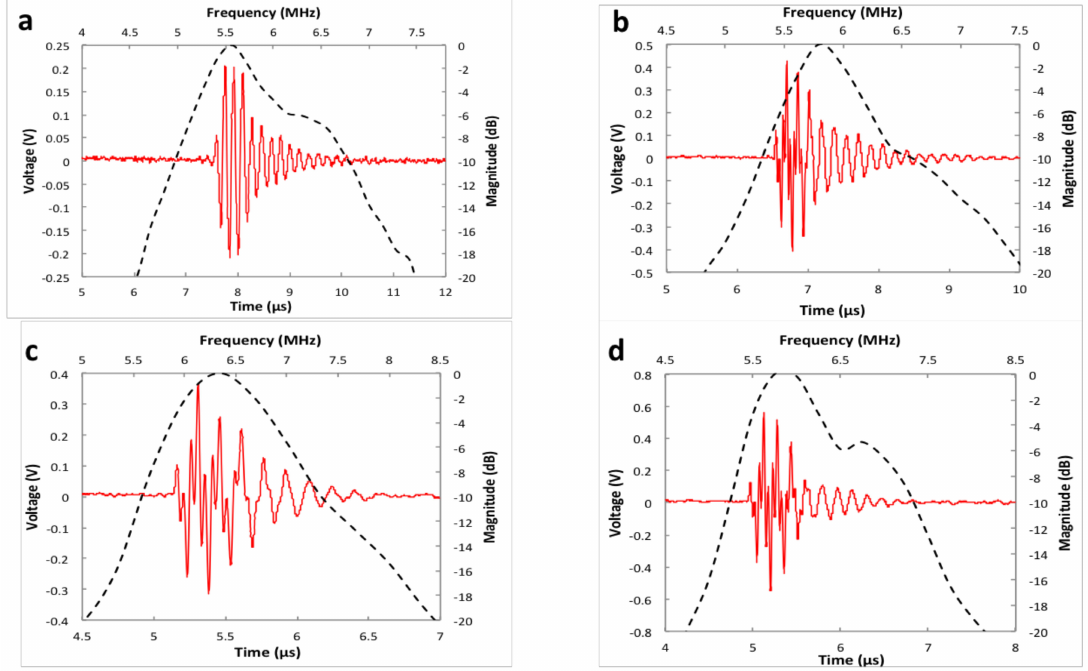
Figure 4. Pulse-echo waveform (solid line) and normalized spectrum of element 1 ( a ), element 2 ( b ), element 3 ( c ) and element 4 ( d